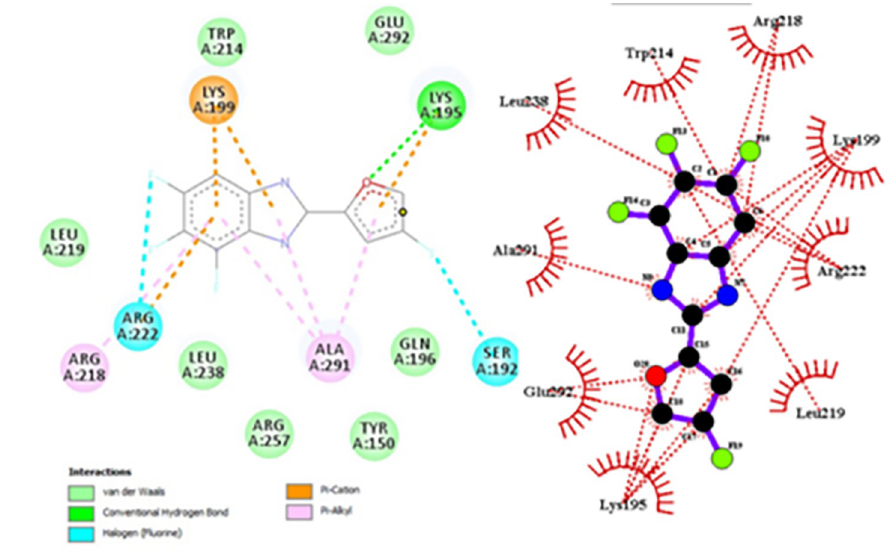
Fig 11. 2D depiction of docking of 5g in the active site of human serum albumin .